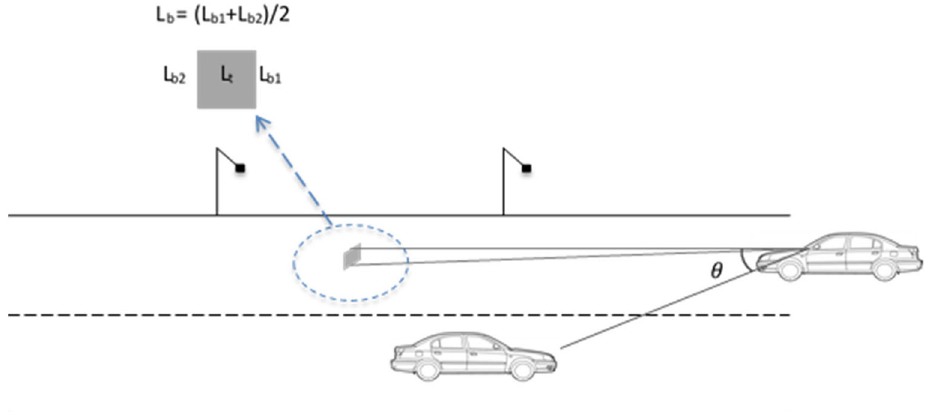
Fig. 1 Schematic layout of experiment field in detection point. Luminance refers to luminous intensity per unit projected area. L b refers to the background luminance and L t refers to the target